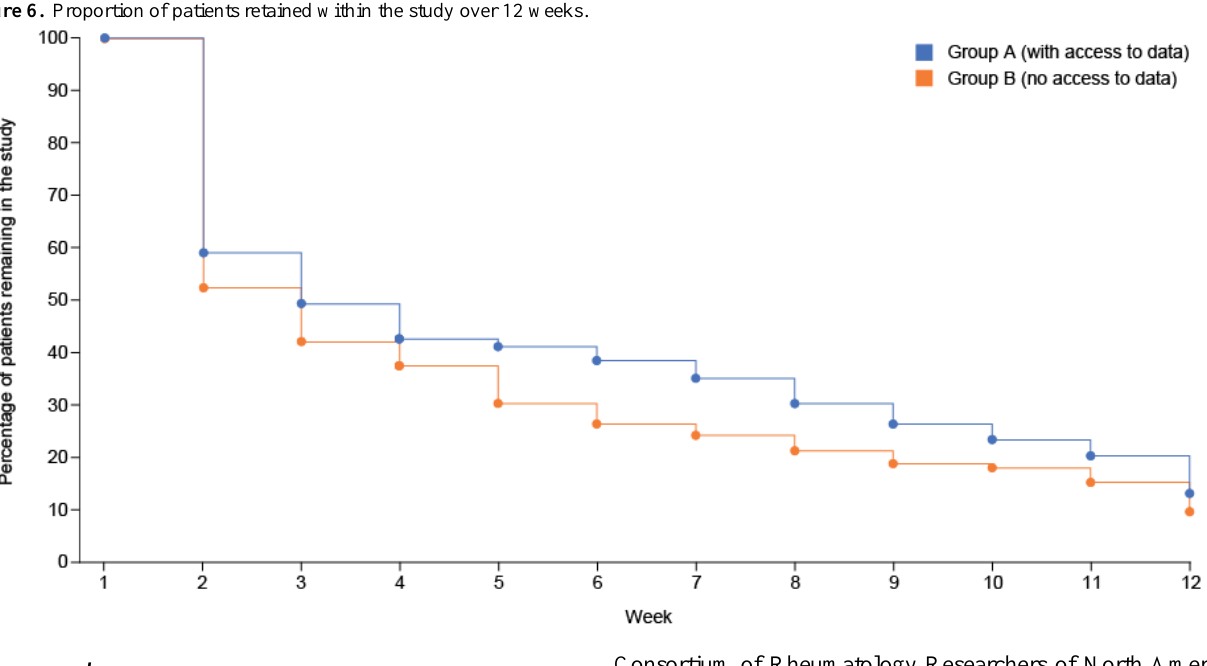
Figure 6. Proportion of patients retained within the study over 12 weeks.